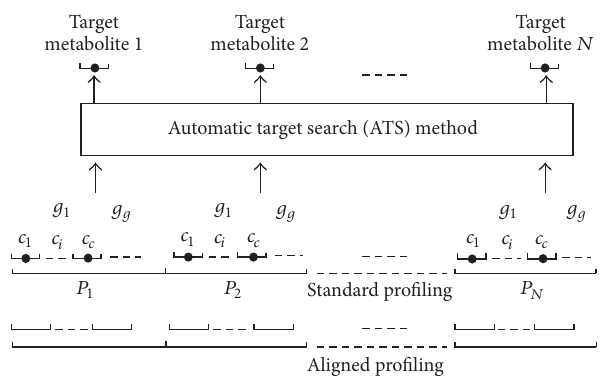
Figure1:PartitionofthestandardprofileusingtheATSmethodand an illustration of how to find the target components as a reference for